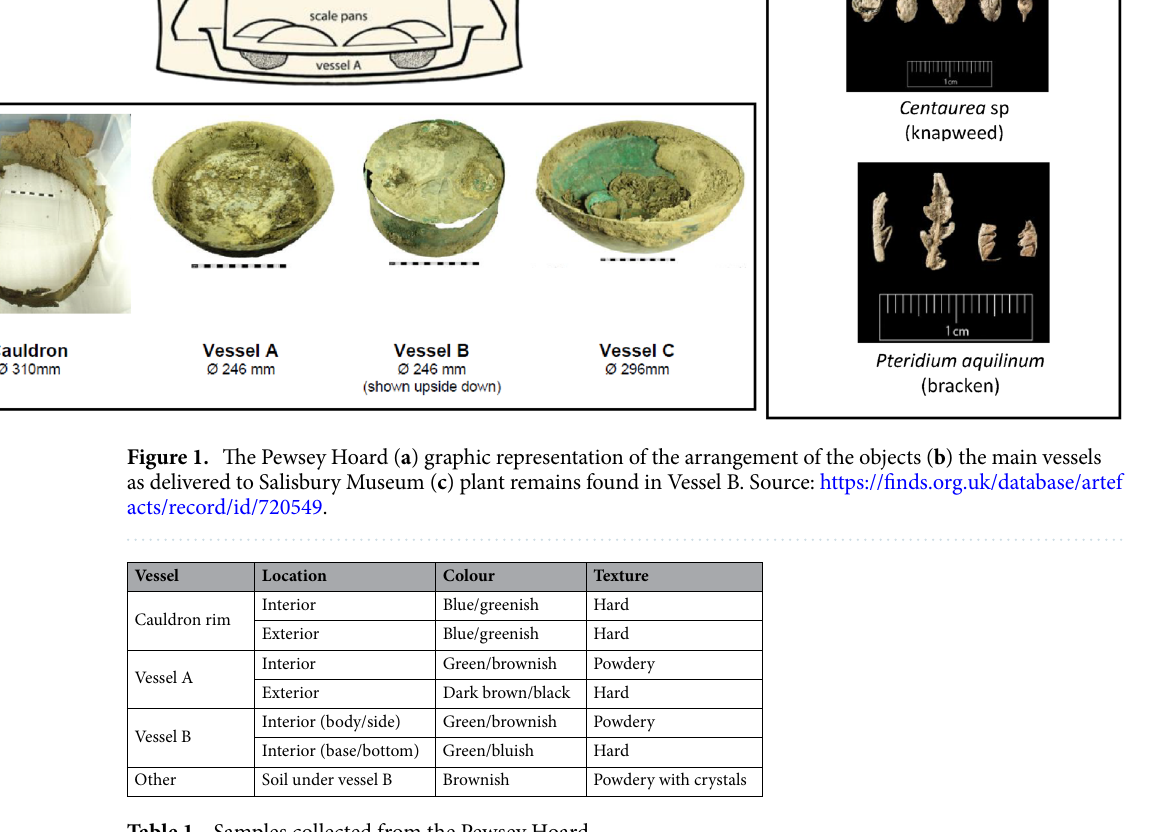
Table 1. Samples collected from the Pewsey